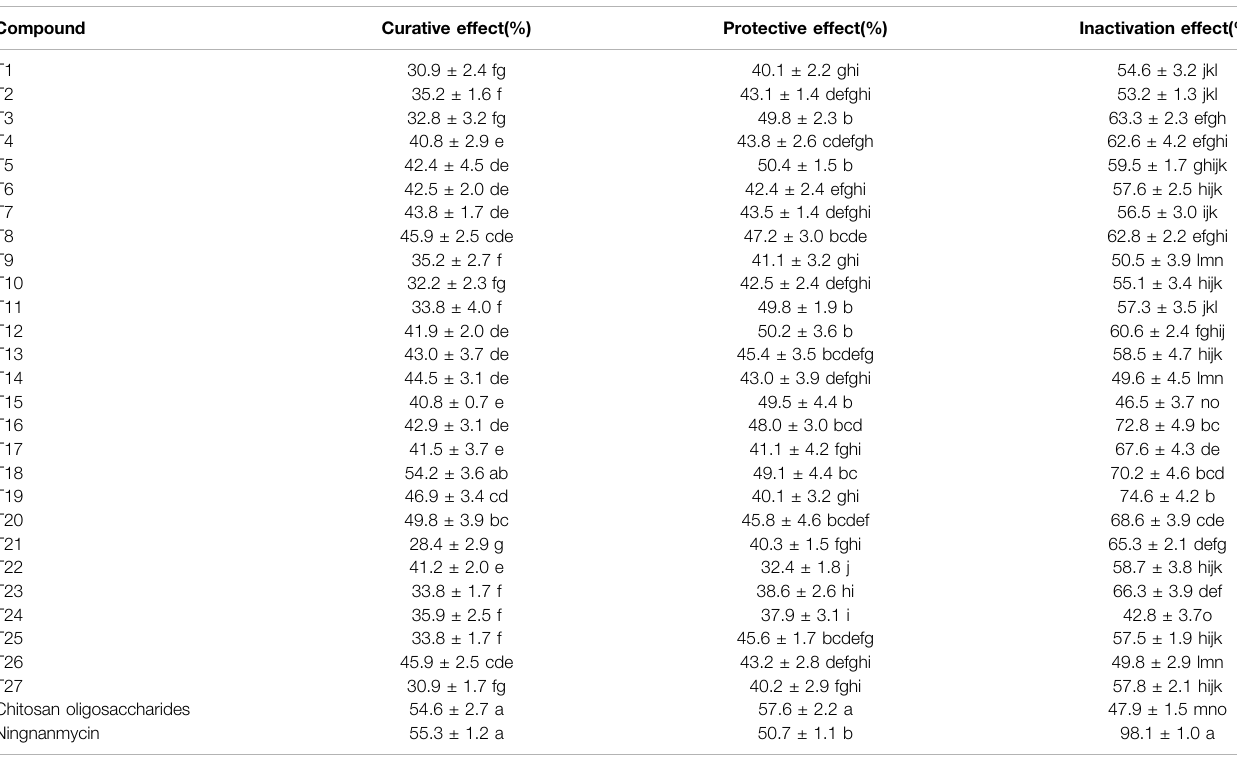
Note: Data in the table are mean ± SD., Different lowercase letters in the same column indicate signi fi cant difference at p < 0.05 level by Duncan ’ s new multiple range test.